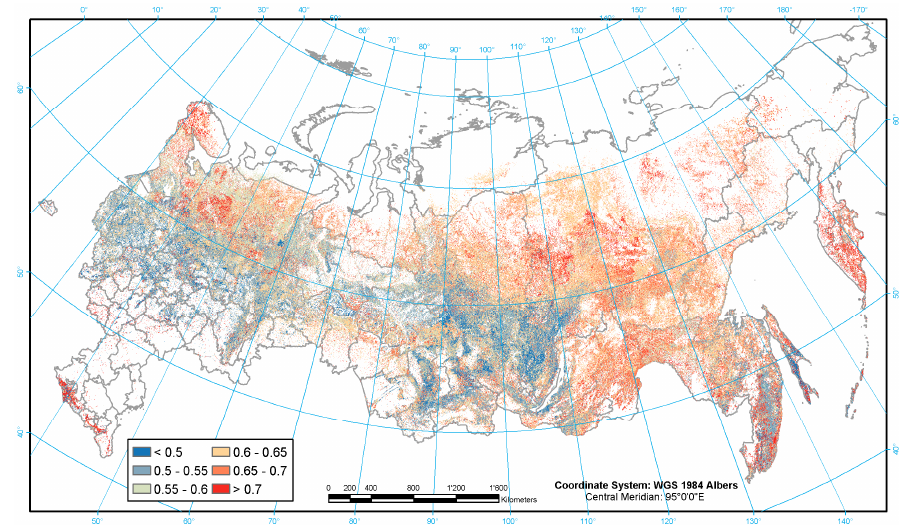
Figure 3. Geographical distribution of biomass conversion and expansion factors ( BCEF , t m − 3 ). Forests 2017 , 8 , x FOR PEER REVIEW